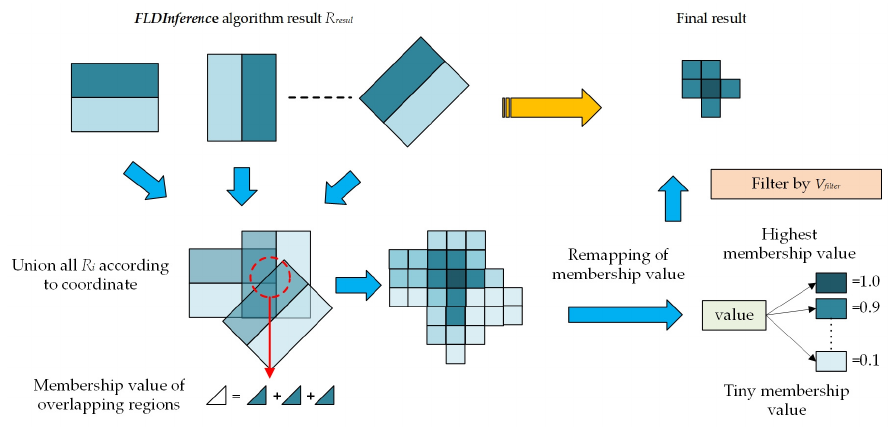
Figure 4. Merging process of the results.